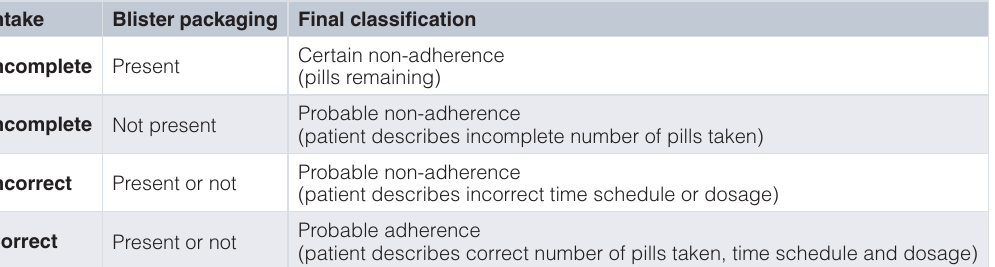
Table 1. Final classification scheme of patients, according to the treatment intake and the presence of the medication blister packaging.